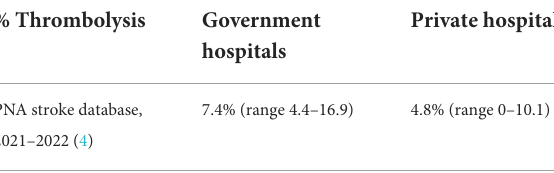
TABLE 1 Average thrombolysis rates in different hospitals, PNA stroke database,